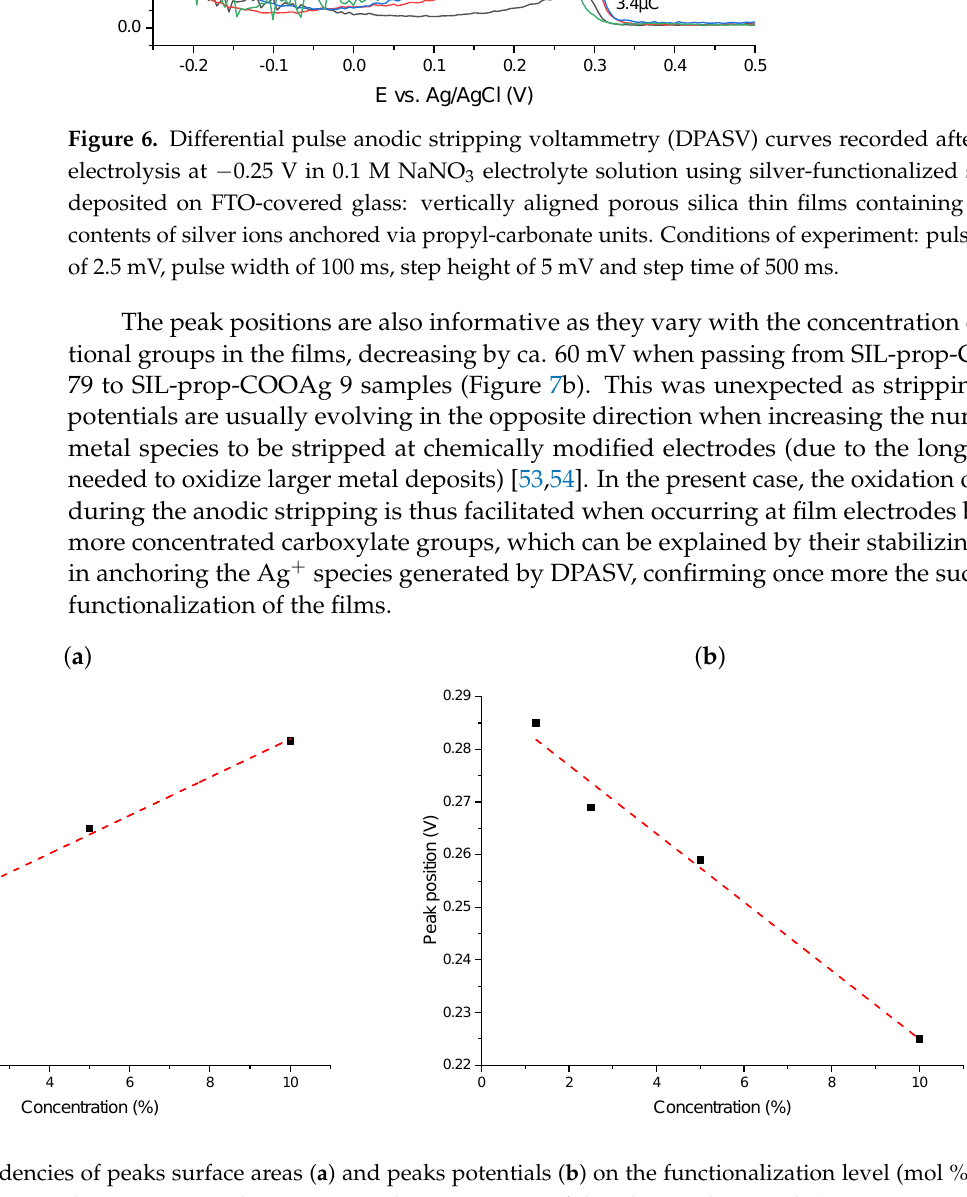
Figure 7. The dependencies of peaks surface areas ( a ) and peaks potentials ( b ) on the functionalization level (mol % of BNTES in the synthesis medium, corresponding to assumed concentration of the silver in the samples). Data originates from experiments of Figure